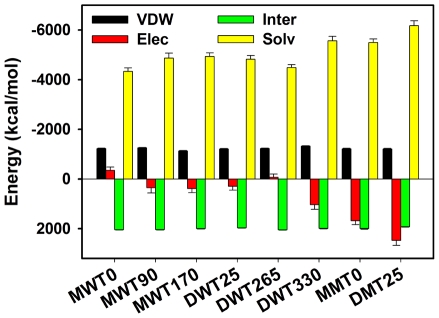
Energy decomposition for all globulomers averaged from the last 10 ns simulations.